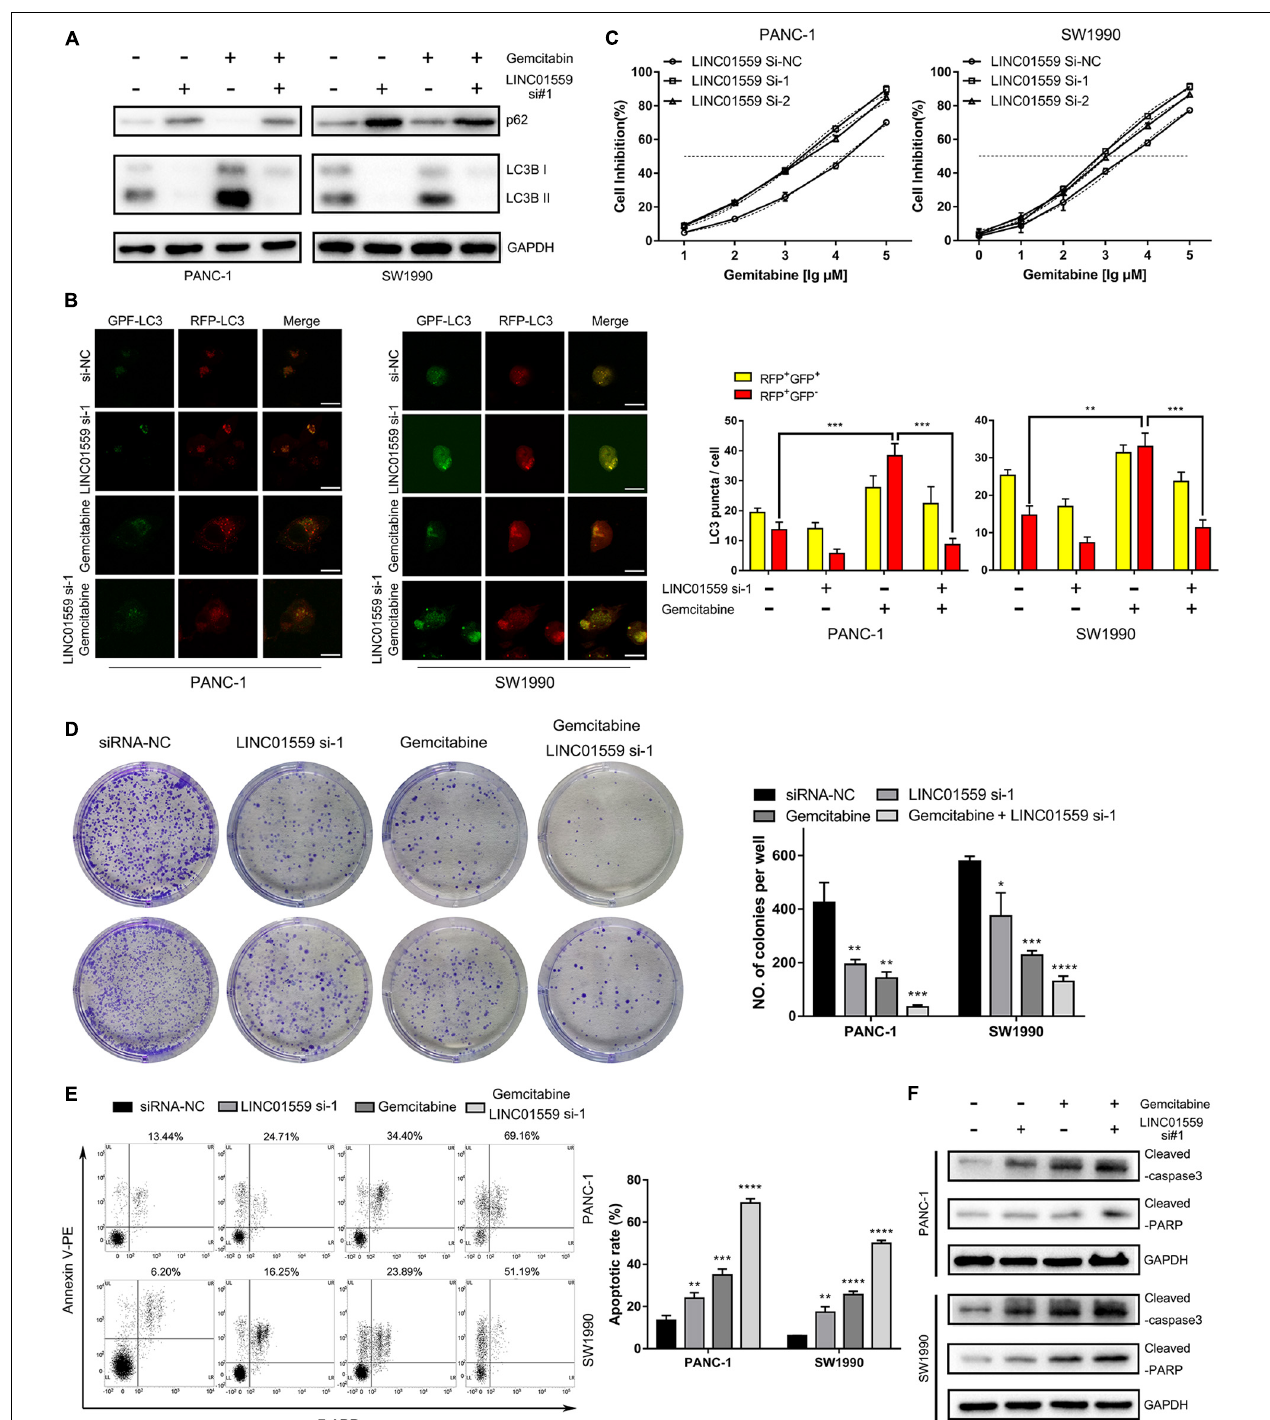
FIGURE 11 | Inhibition of LINC01559 suppressed PC cell autophagy and promoted apoptosis. (A) Protein expression levels of p62 and LC3B after various treatments measured by Western blot analysis. (B) Representative confocal images of autophagosome (yellow puncta) and autolysosome (red puncta) formation are presented in the left panel. Scale bar: 20 µ m. The numbers of RFP + GFP + LC3 puncta and RFP + GFP − LC3 puncta are shown in the right panel. (C) The cell inhibition was calculated by the CCK-8 assay in PC cells treated with different concentrations of gemcitabine at 48 h. (D) Representative images from the clonogenic assays of PANC-1 and SW1990 cells with or without gemcitabine (10 µ M) treatments and cultured for 14 days. (E) Apoptosis rate after various treatments was detected by flow cytometry. (F) Protein expression levels of cleaved PARP and cleaved caspase-3 after various treatments measured by Western blot analysis (* p < 0.05; ** p < 0.01; *** p < 0.001; **** p < 0.0001; ns, not significant).